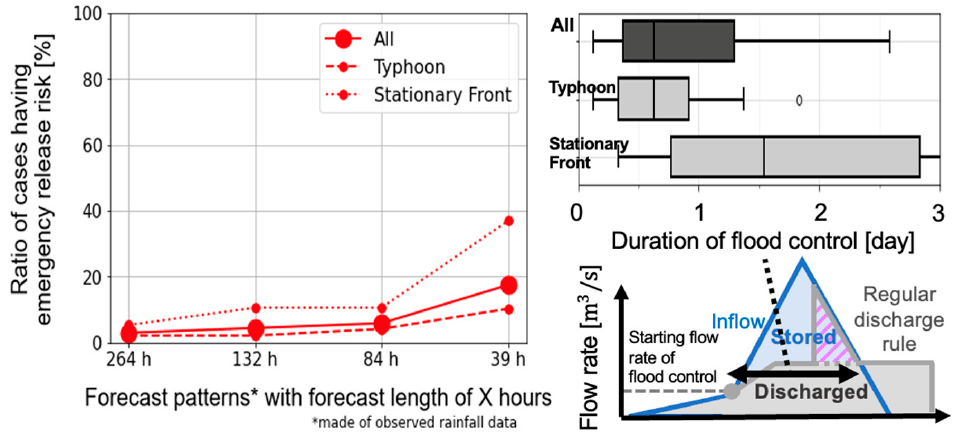
Figure 15. ( Left ) ratio (%) of cases with an emergency release risk when using four different forecast lengths for all pre-release cases. Perfect accuracy for the lengths was assumed. ( Right ) boxplots of durations (day) of flood control in all pre-release cases.